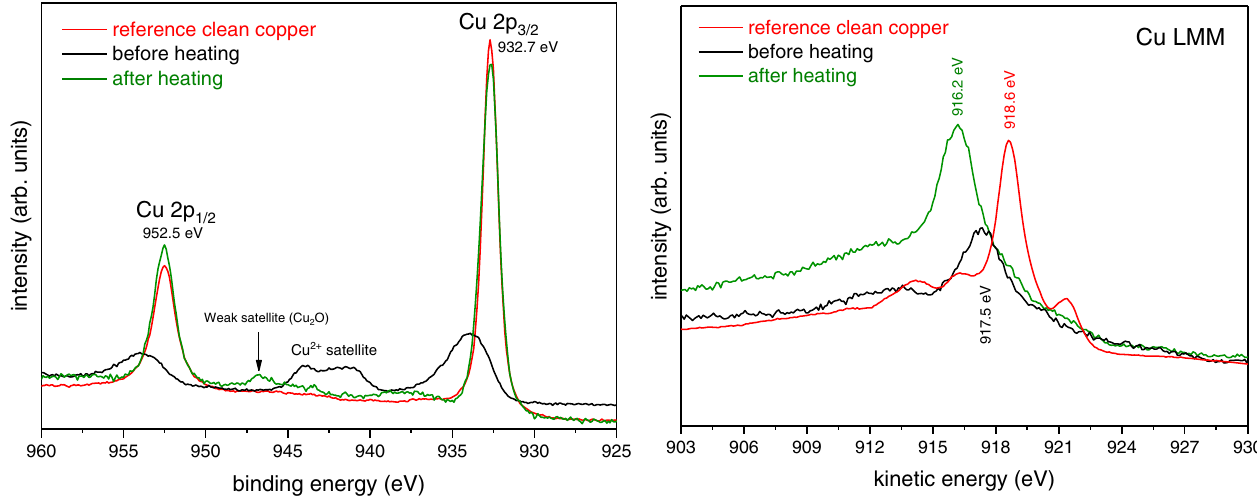
FIG. 4. X-ray photoelectron spectra of the Cu 2p state (left) and the Cu LMM Auger transition (right) of sputter-cleaned copper (red line) and CH-patterned air-treated copper before (black line) and after (green line) the thermal treatment in a